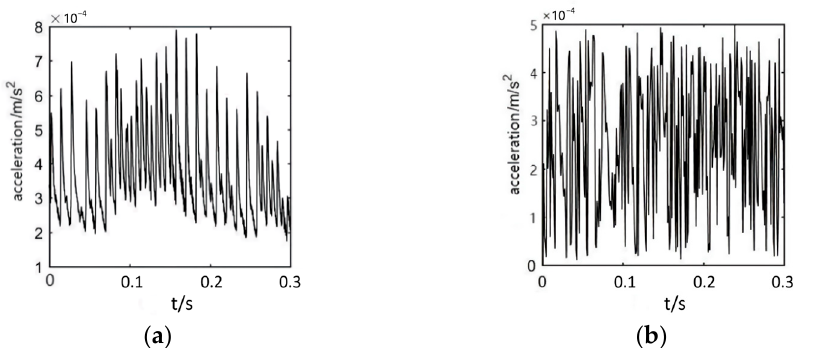
Figure 4. Vibration acceleration curve of the submarine cable. ( a ) Vibration acceleration curve at the moment of anchor smashing; ( b ) vibration acceleration curve at the moment of scouring.